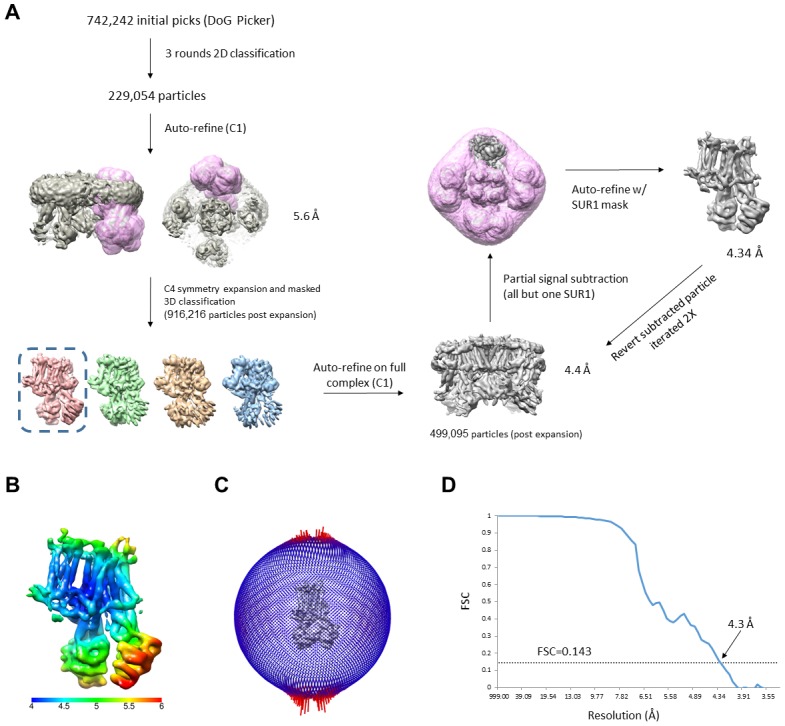
Data processing workflow for the CBZ/ATP state.(A) Overview of data processing workflow. Particle picking was performed automatically with DoGPicker and manual inspection. All other image processing steps were performed in RELION-3. (B) Local resolution plot of locally refined SUR1 map. (C) Angular distribution plot. (D) Fourier shell correlation (FSC) of two independent half maps of locally refined SUR1.